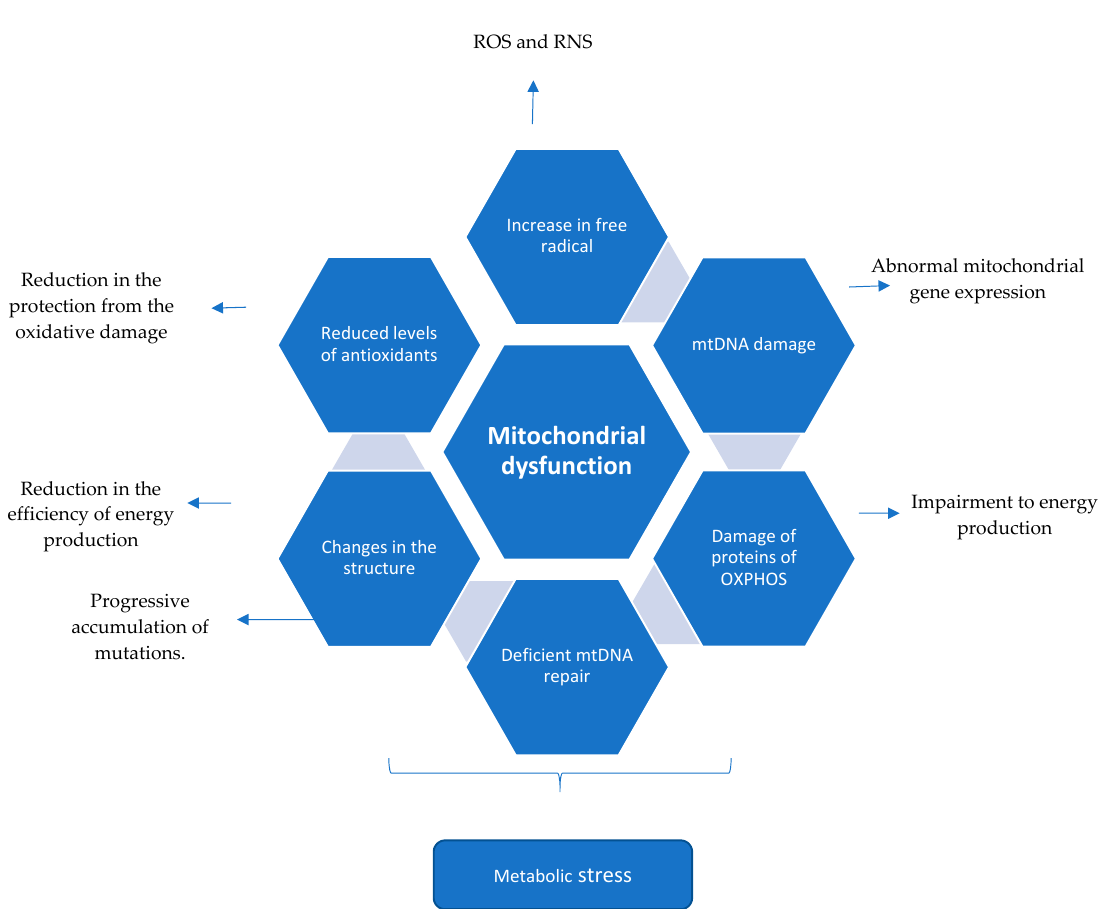
Figure 1. Mitochondrial dysfunction described in the literature associated with Multiple Sclerosis. Chronic neuroinflammation leading to mitochondrial